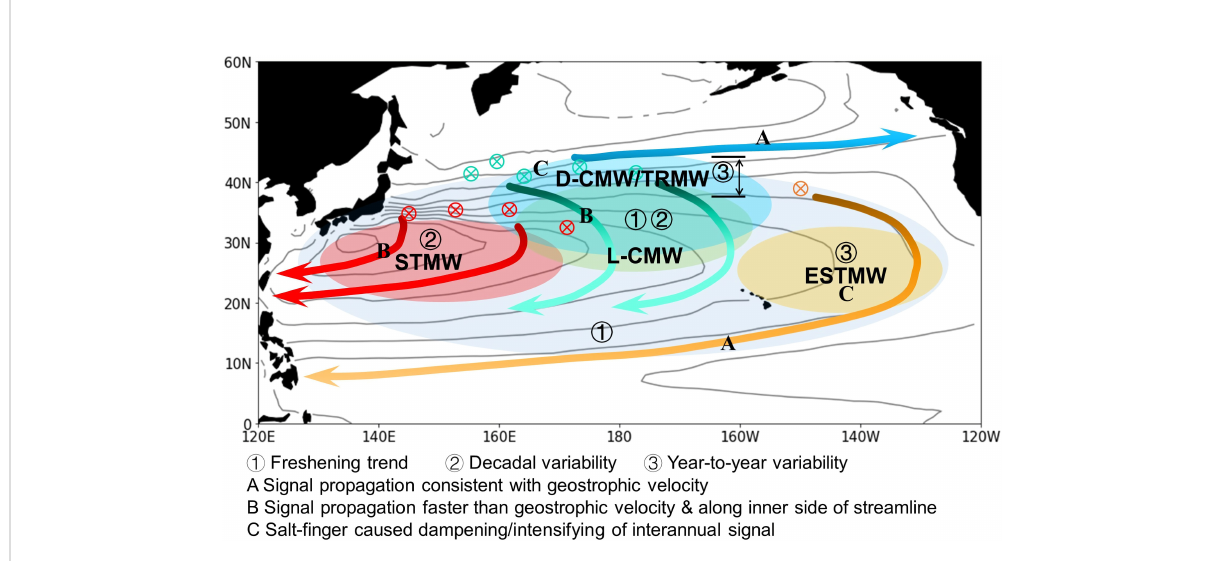
FIGURE 15 A schematic map illustrating the propagation pathways of the spiciness anomalies. Gray contours in the background indicate streamlines that were averaged on g = 24.4 – 26.5. Crosses with a circle indicate subduction of the mixed layer salinity